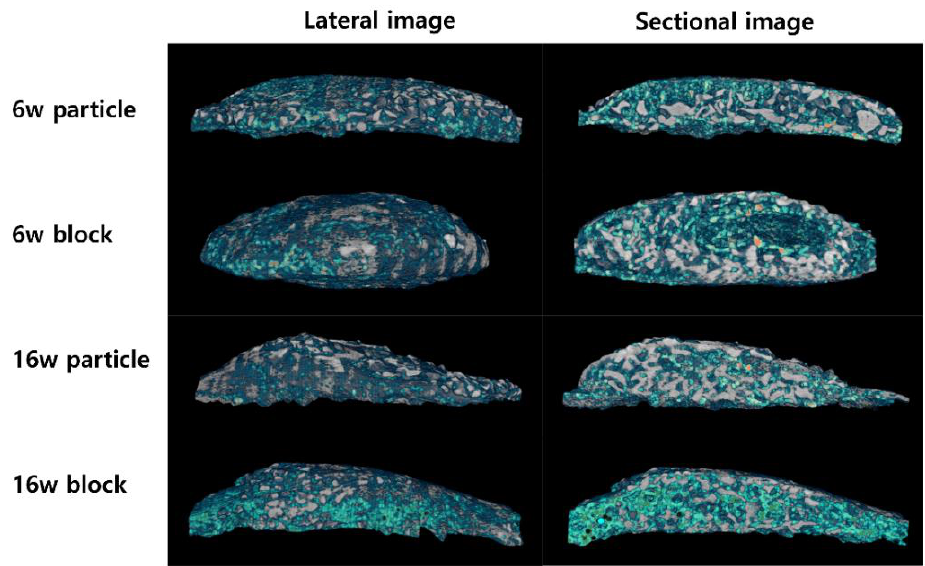
Figure 2. Three-dimensional (3D) reconstruction images from micro-computed tomography ( µ -CT) analysis of 6w particle, 6w block, 16w particle, and 16w block groups showing the newly formed bone (green light) and grafted bone scaffold (white light).